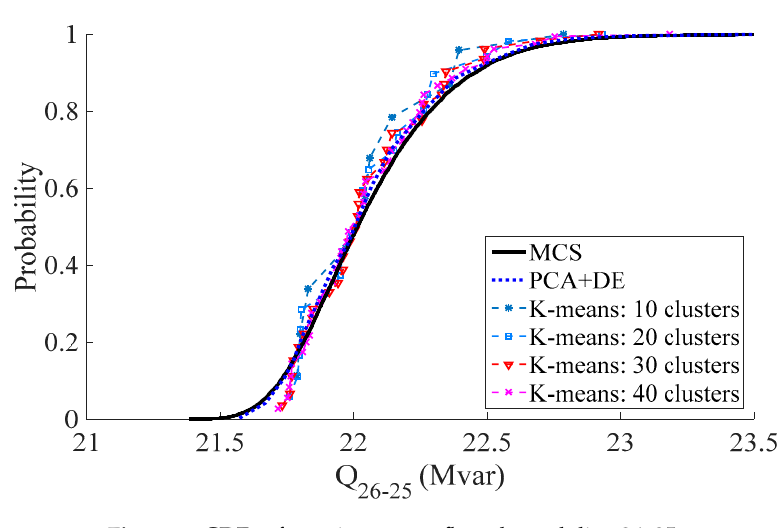
Figure 2. CDFs of reactive power flow through line 26–25.